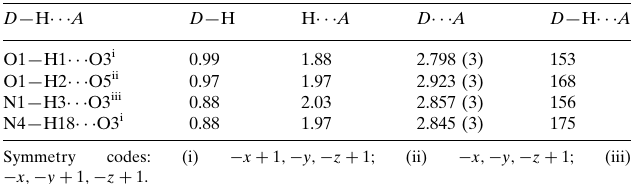
Hydrogen-bond geometry (A˚ , (cid:1)